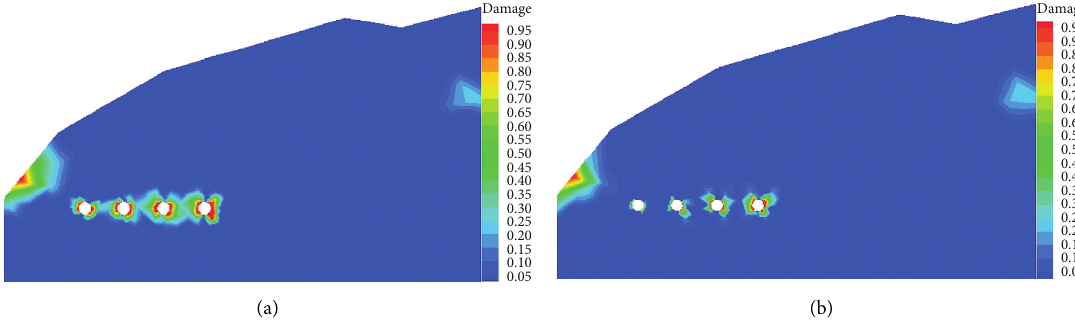
Figure 11: The damage nephogram with different support patterns. (a) Without lining after excavation. (b) With lining after